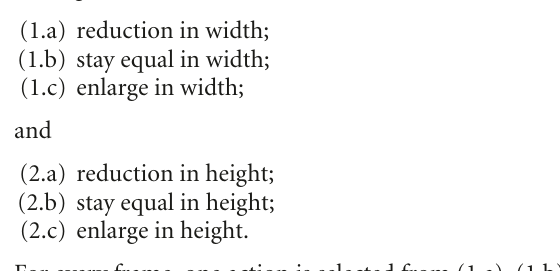
Figure 6: A macroblock m i , j divided into four 8 overlapped by an T ( x , y ) element. The figure shows how to deter- mine d x and d y and the overlapping percentages P 1 to P 4 .